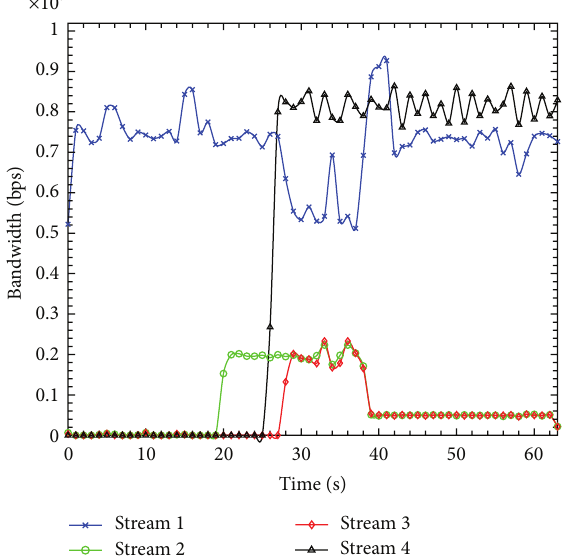
Figure 14: QoSiLAN